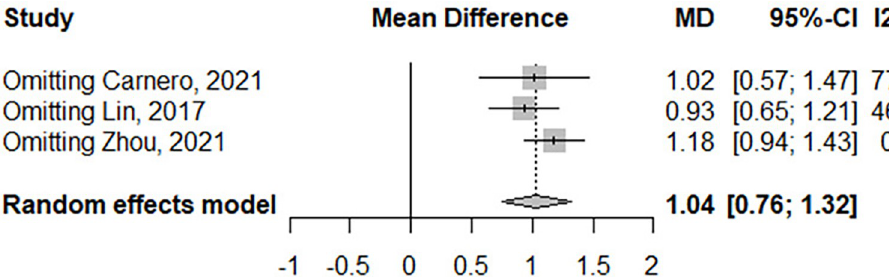
Fig 3. Mean difference in the neutrophil-to-lymphocyte ratio (NLR) between NMOSD patients and healthy controls according to the exclusions of each study.